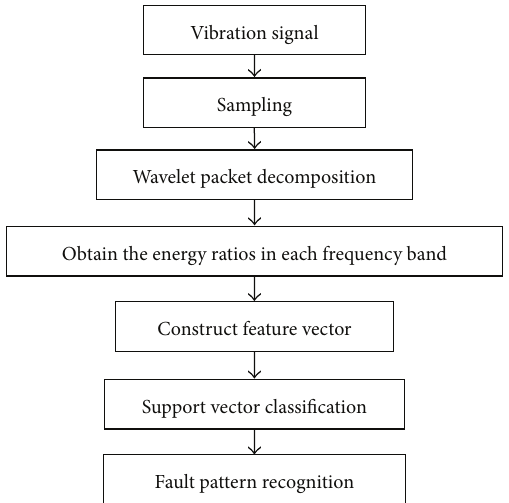
Figure 1: Fault pattern recognition flowchart.